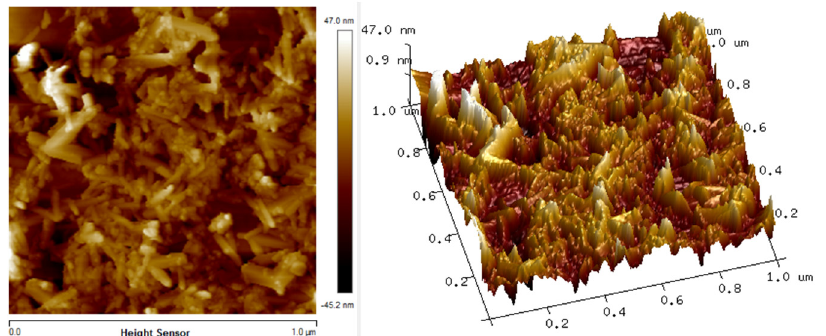
Figure 4. AFM image of Fe 2 O 3 thin film.